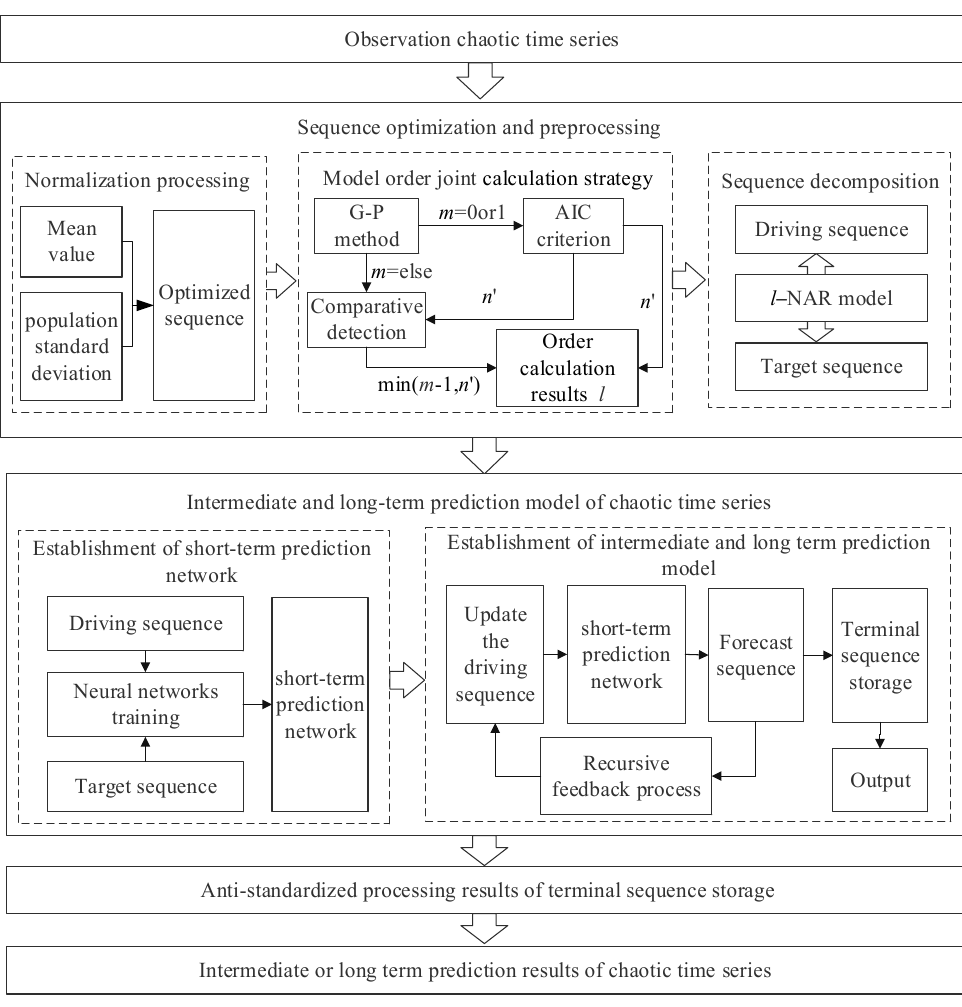
Figure 1. The principle of the ILTP method.